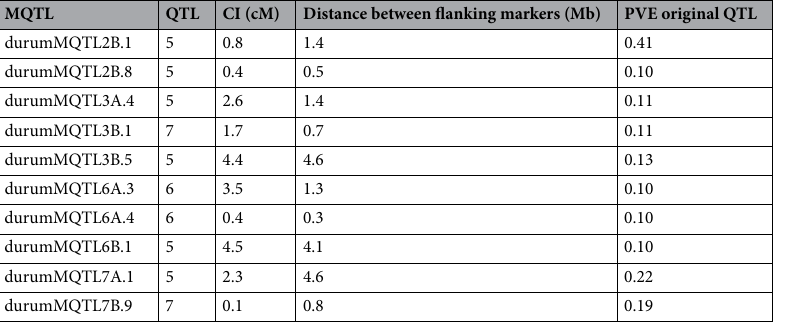
Table 4. Selected MQTL.